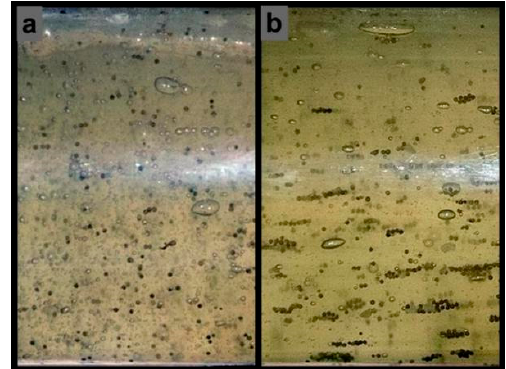
Figure 6. Physical map of the test section: ( a ) Diagram of the contraction section; ( b ) installation drawing of the samples; ( c ) particle surface morphology scanned by SEM.